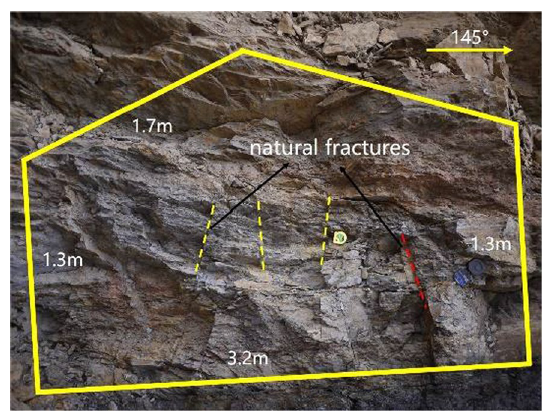
Fig. 1 Shale outcrop of the Carboniferous Hurleg Formation in the eastern Qaidam Basin (Zhang et al. 2016)